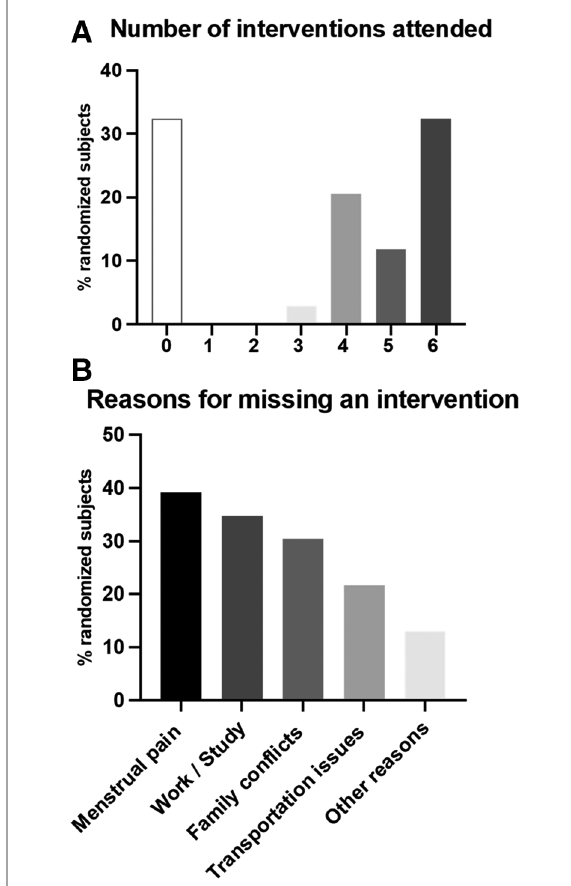
FIGURE 3 Participation rate of study subjects in the EE intervention. Full dose and half dose are shown in panel A . Reasons for missing an intervention were documented via an online survey are shown in panel B